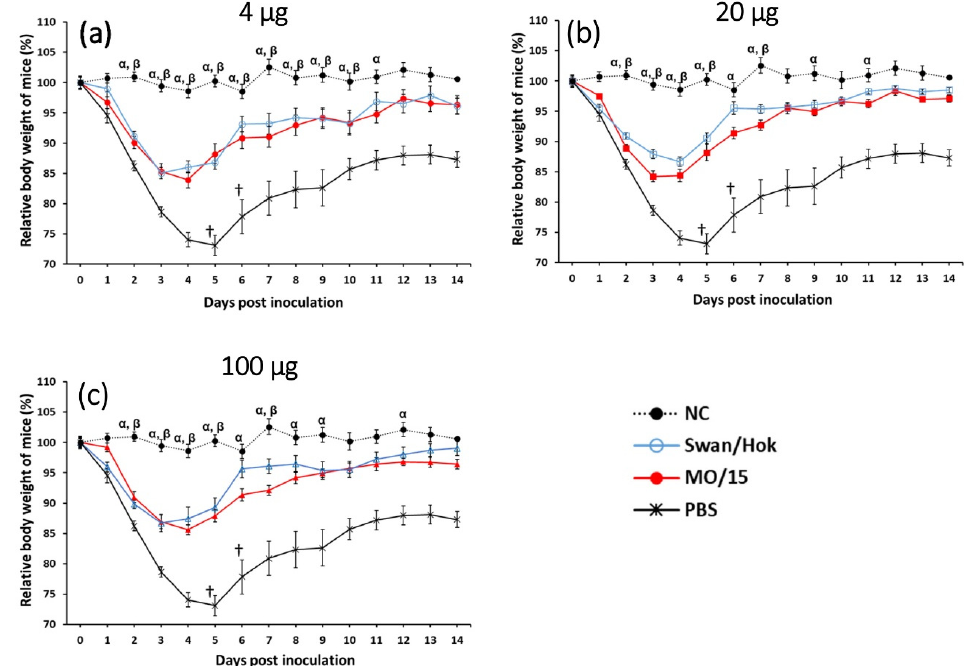
measured on day 3 after the MO/15 challenge. * p < 0.05.